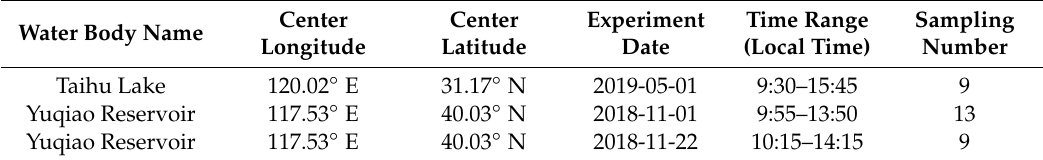
Table 1. Water surface experiment